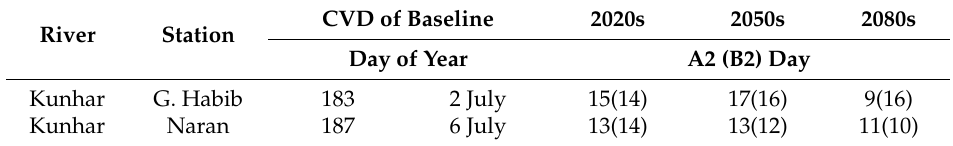
Table 6. Future changes in center-of-volume dates (CVD) with respect to the baseline period (1961–1990) at different streamflow stations under both scenarios, A2 and B2, in the Kunhar River